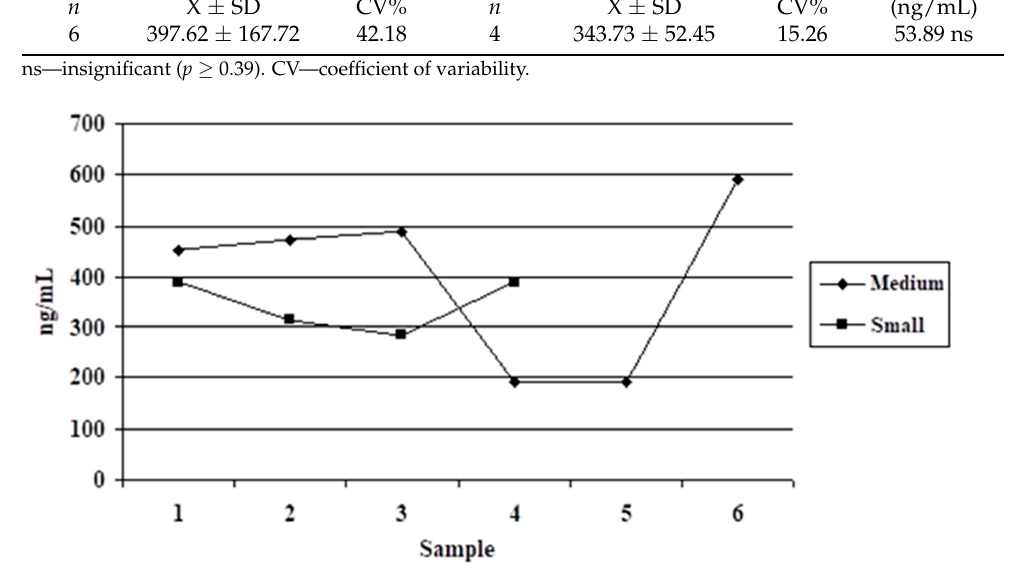
Figure 1. Serotonin dynamics in shelter dogs.